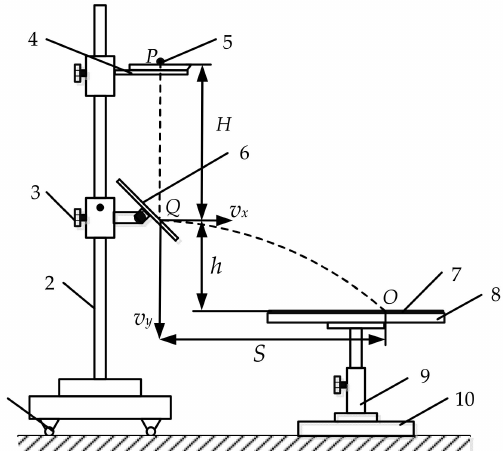
Figure 3. Schematic diagram of the recovery coefficient test device and test principle. 1. The leg; 2. support bar; 3. tightened screws; 4. the feeding rack; 5. material particles; 6. plate collision; 7.